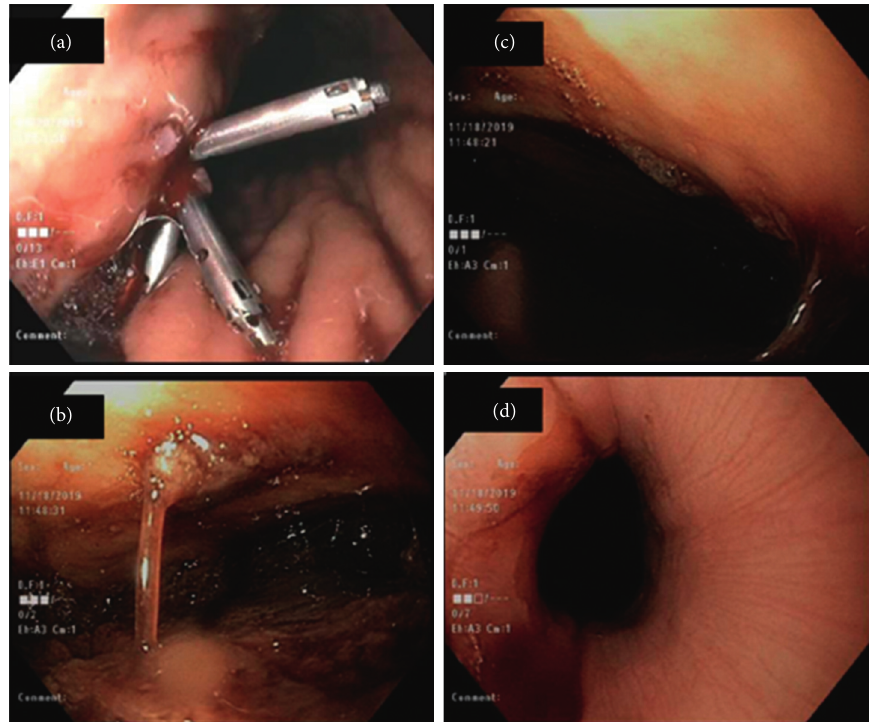
Figure 1: Endoscopy images showing gastrointestinal bleeding. (a) Bleeding gastric ulcer. (b, c) Large blood clots within the gastric body. (d) Blood in the lower third of the